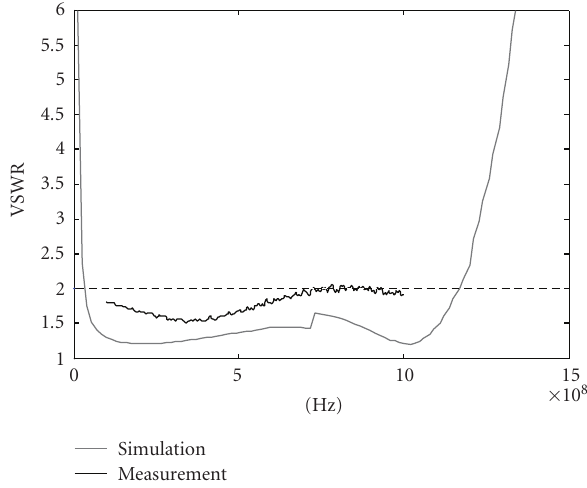
Figure 9: VSWR HMS UWB antenna with rectangular slot.